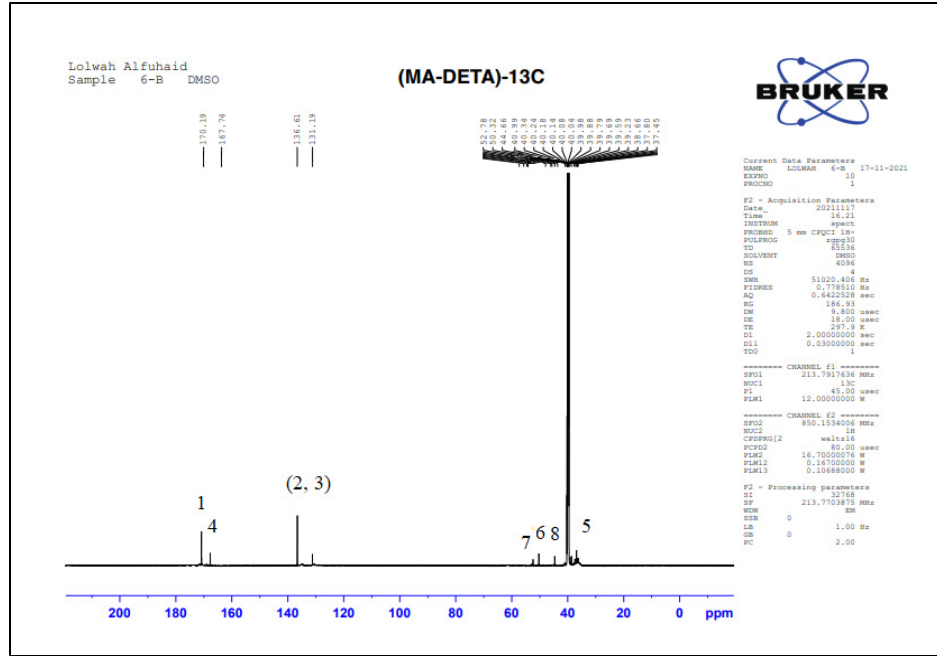
Figure 6. 13 C-NMR chemical shift of the prepared monomer (DETA-MA). Table 1. 13 C-NMR chemical shifts of the prepared monomer